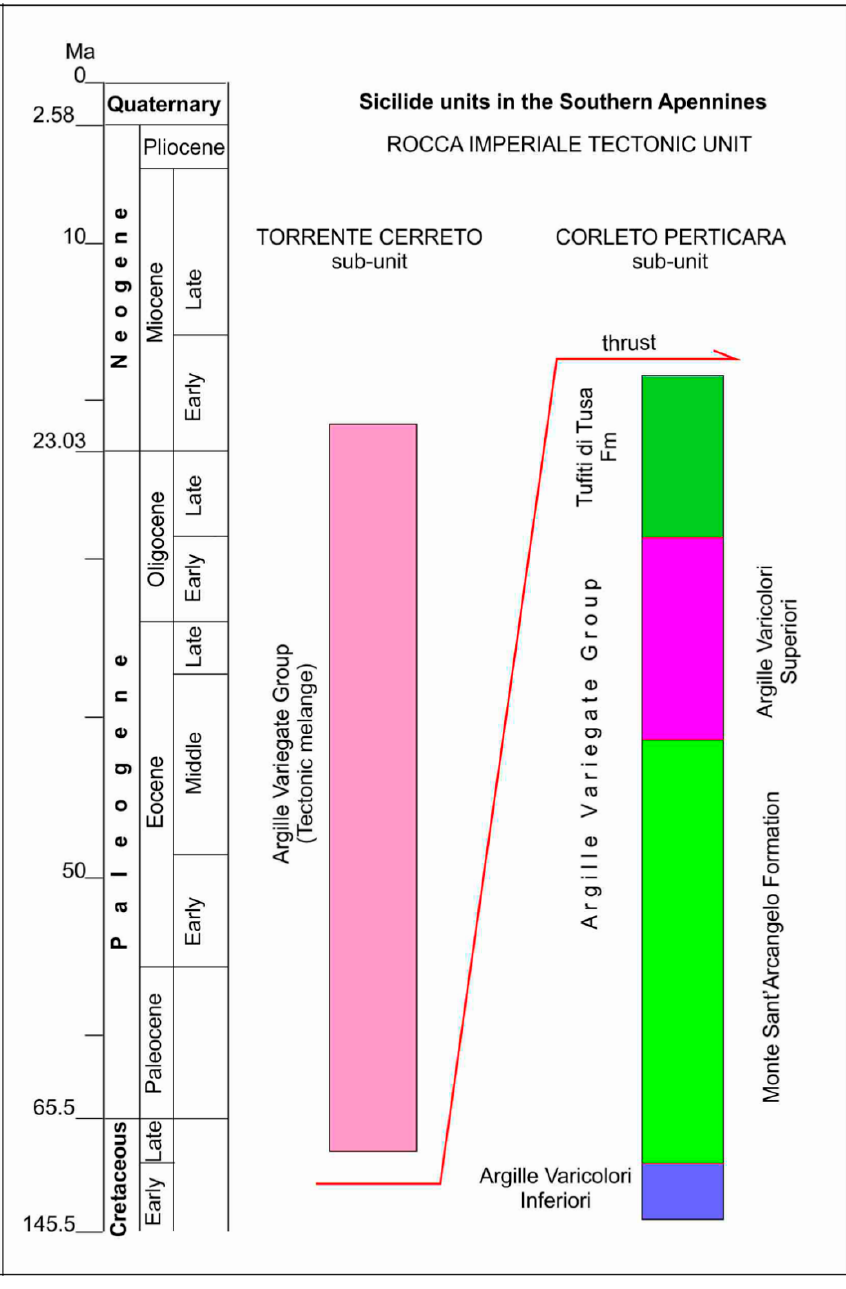
Figure 2. Schematic stratigraphic features of the Sicilidi units in the study area (modified from [32]).